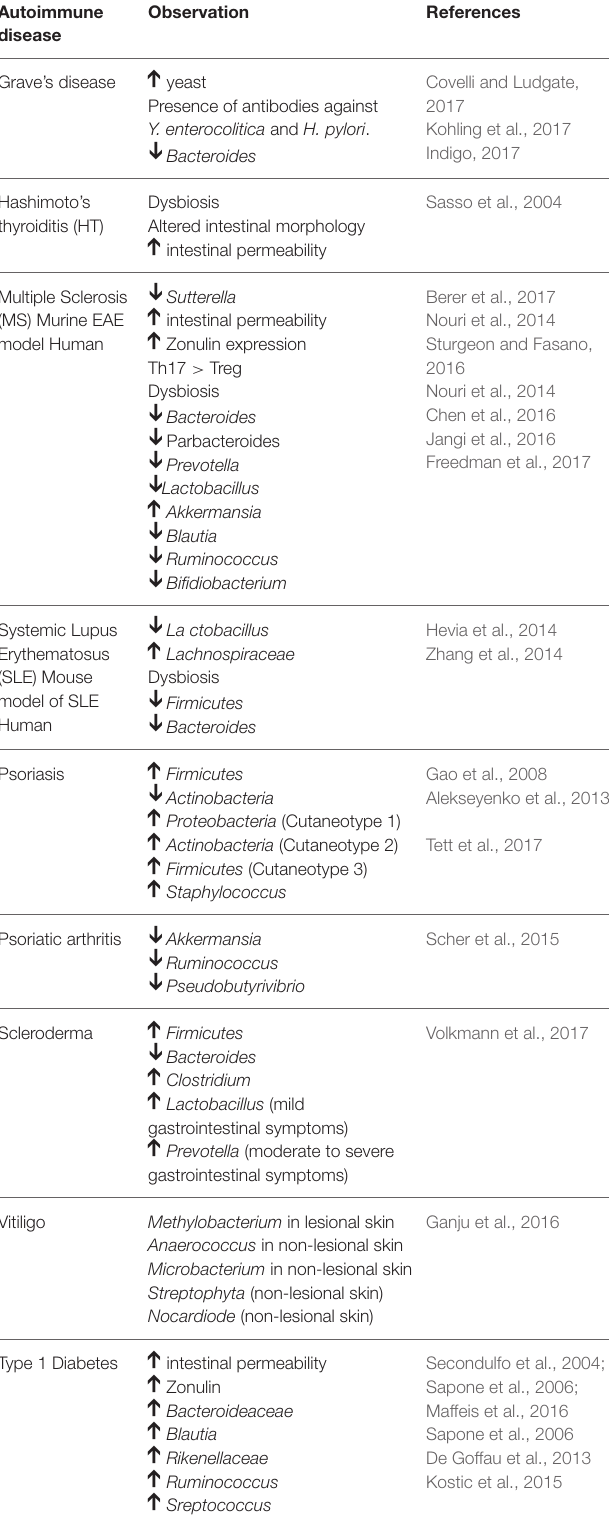
TABLE 1 | Alterations observed in the microbiota in non-intestinal autoimmune